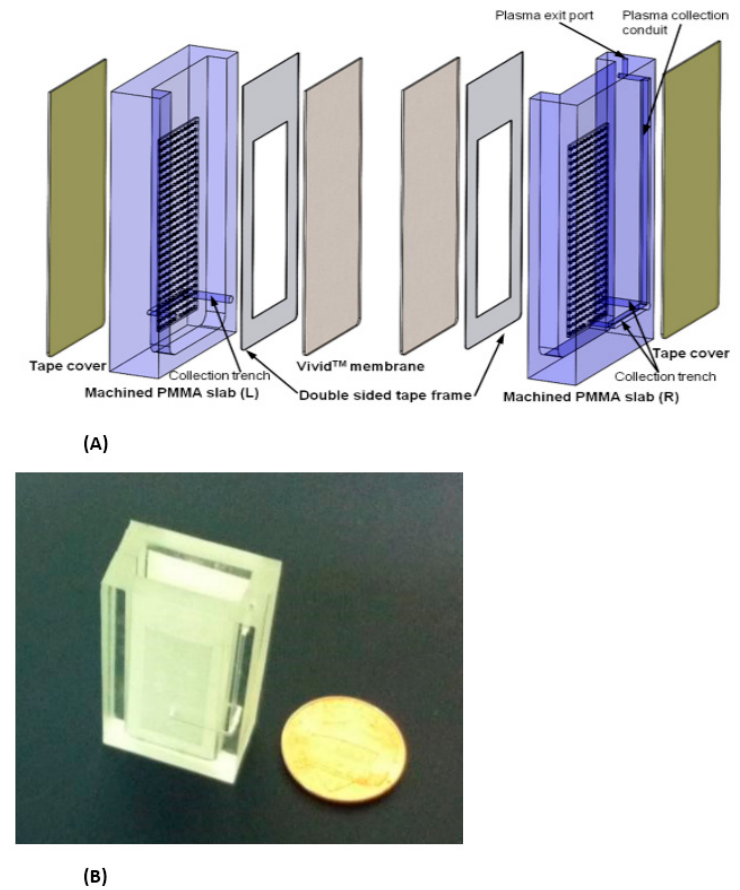
Figure 11. ( A ) Exploded view of pump-free, membrane-based, sedimentation-assisted plasma extraction device. The Vivid™ polysulfone membrane separates plasma from blood cells, and features pores with large (~100 micron) on the whole-blood side that narrow to ~2-micron diameter on the plasma side. ( B ) assembled module. From [163].